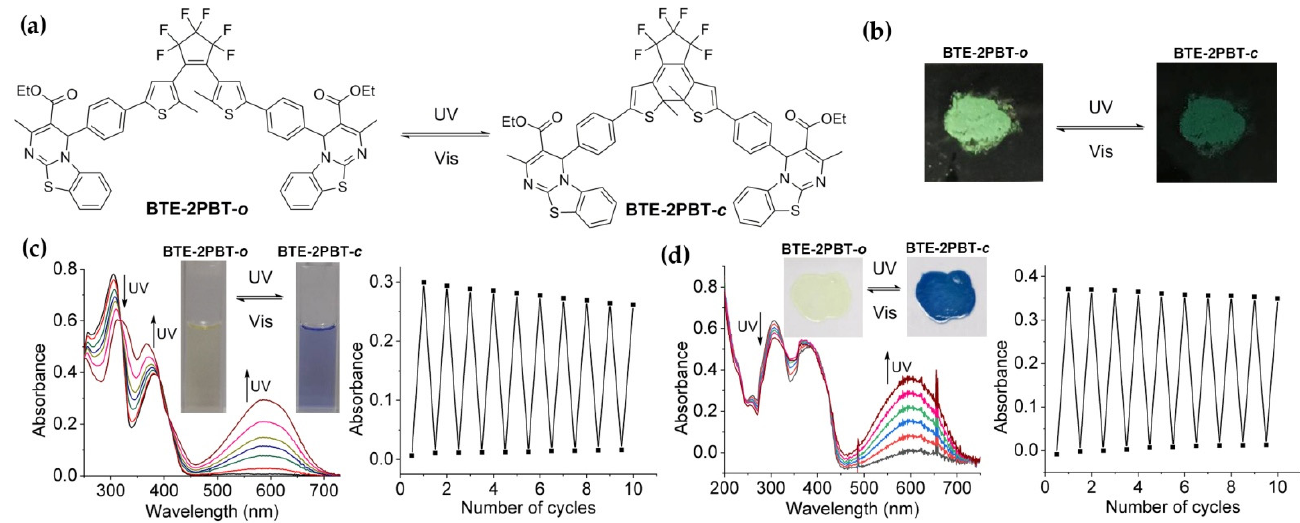
Figure 1. Photochromic properties of BTE-2PBT triad. ( a ) Photochromic reactions of BTE-2PBT ; ( b ) Photochromism of BTE-2PBT in solid state; ( c ) Absorption change and fatigue resistance of BTE-2PBT in hexane (2.0 × 10 − 5 M) upon photochromism; ( d ) Absorption change and fatigue resistance of BTE-2PBT in PMMA film (5 wt %) upon photochromism. Table 1. Photochromic Parameters of BTE-2PBT and a Reference Bisthienylethene ( 3 ) a .